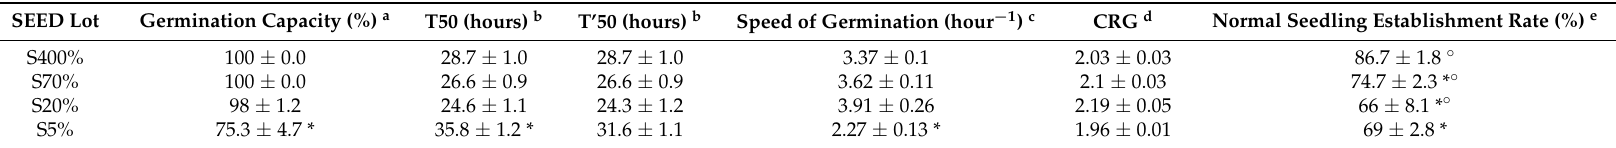
Table 2. Germination indexes and normal seedling rate of Brassica napus seeds obtained from plants well S supplied and grown under S-limited conditions. Values correspond to means ± SE (n = 3). Seeds were obtained from plants subjected to plethoric S nutrition (400% of plant S needs provided, S400% seeds) or subjected to a